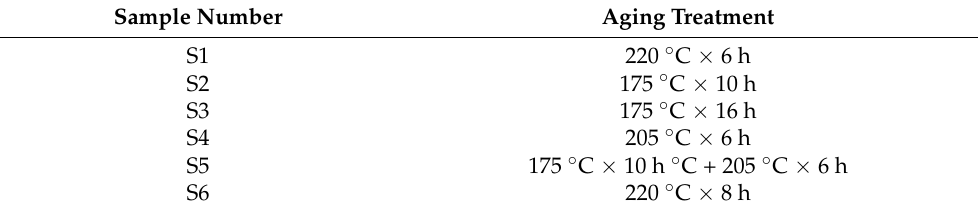
Table 2. Aging process of six